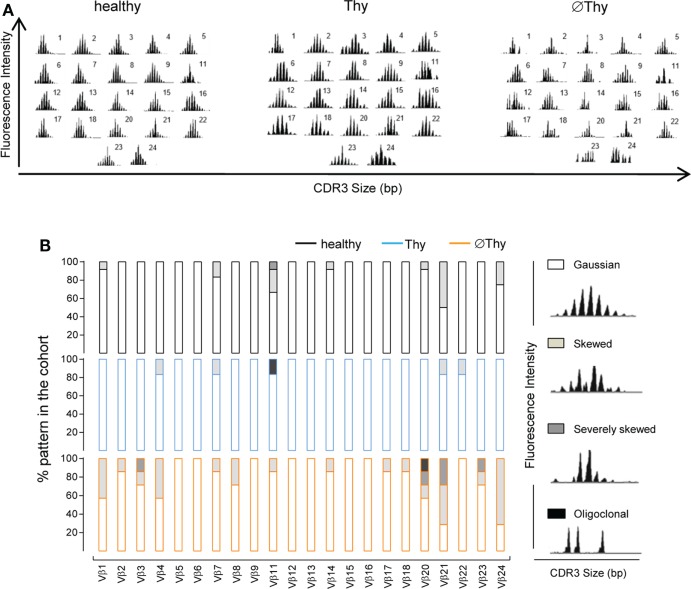
Spectratyping analysis of naive CD4 T-cell diversity in adults thymectomized early in life. CD3 length distribution within each of the 22 Vβ families of purified naive CD4 T-cells analyzed by spectratyping: (A) illustrative examples from thymectomized patients without (right, ∅Thy1 in Table S1 in Supplementary Material) and with evidence of thymic activity (middle, Thy6 in Table S1 in Supplementary Material), as well as age-matched healthy (left) individuals; (B) proportion of the illustrated patterns within each Vβ family in the three cohorts (∅Thy, bottom, n = 7; Thy, middle, n = 6; healthy, top, n = 12).